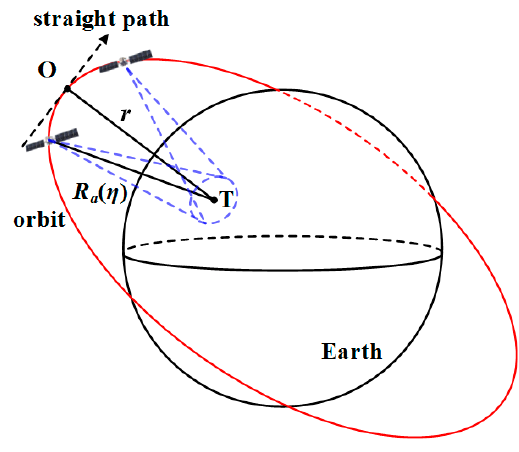
Figure 1. Geometry of spotlight spaceborne SAR.